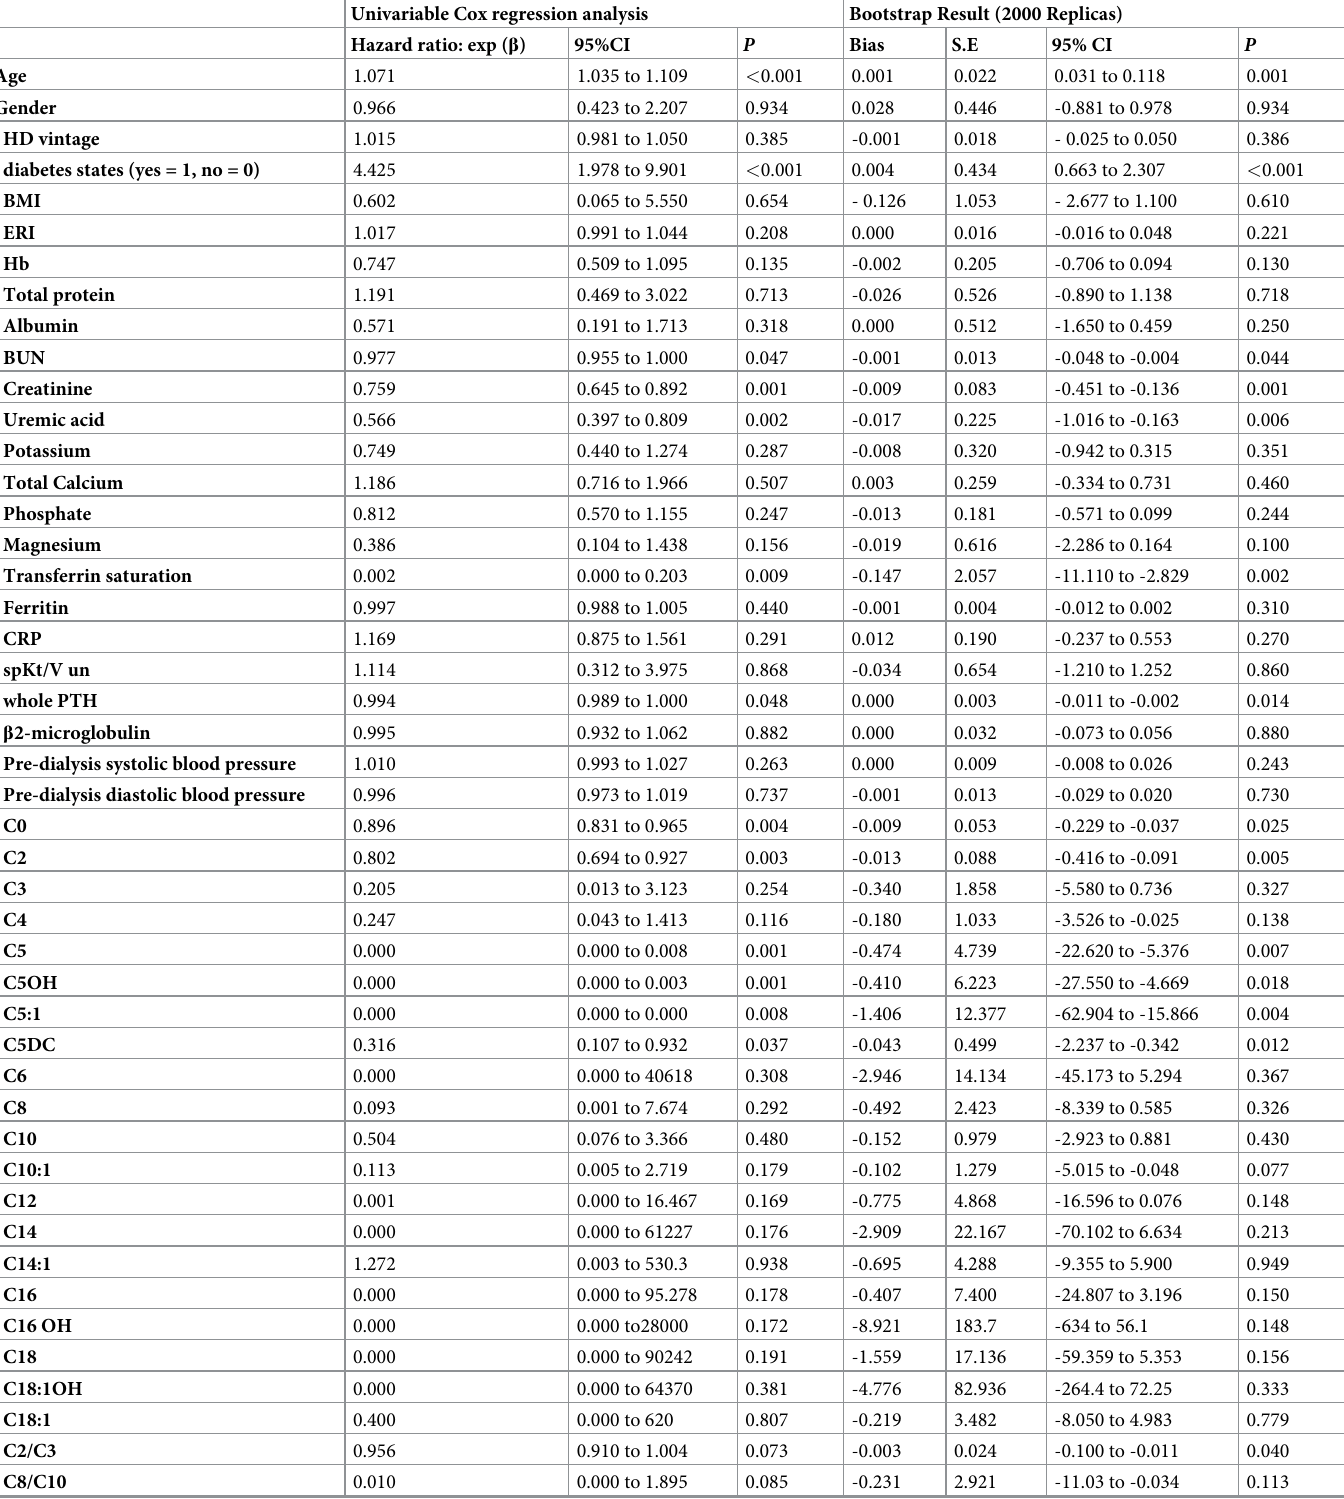
Table 3. Univariable Cox regression analysis of the correlates of mortality, baseline characteristics, carnitine profile, and bootstrap